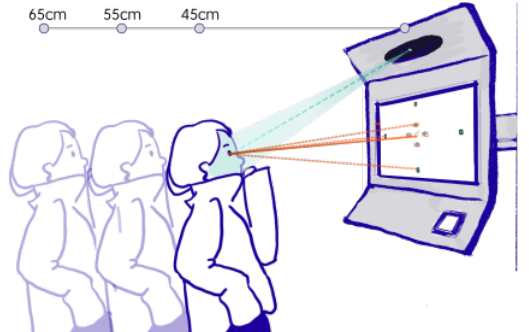
Figure 1. Visualization of ordering on a vending machine with gaze interaction in the real-world